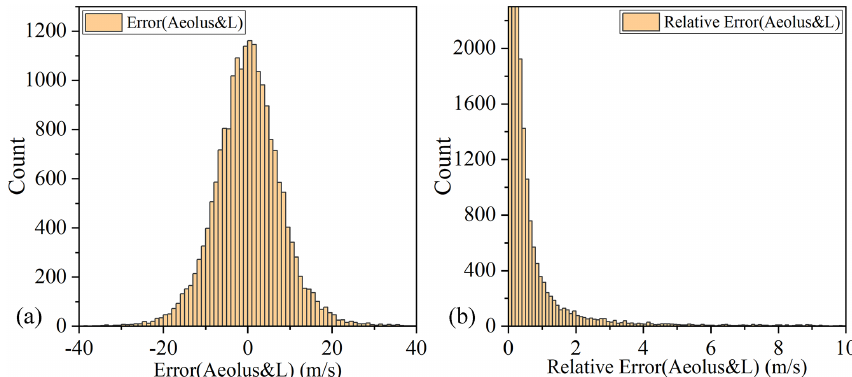
Figure 7. Statistical distribution of the error (a) and relative error (b) between Aeolus detection and L-band RS data. The data were from the Rayleigh-clear group for 12 months in Chifeng.